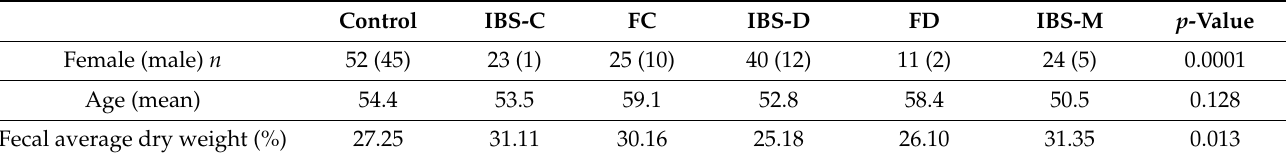
Table 2. Characteristics of the participants of the COMFORT cohort used for the bile acid analyses, including average fecal dry weight percentage by